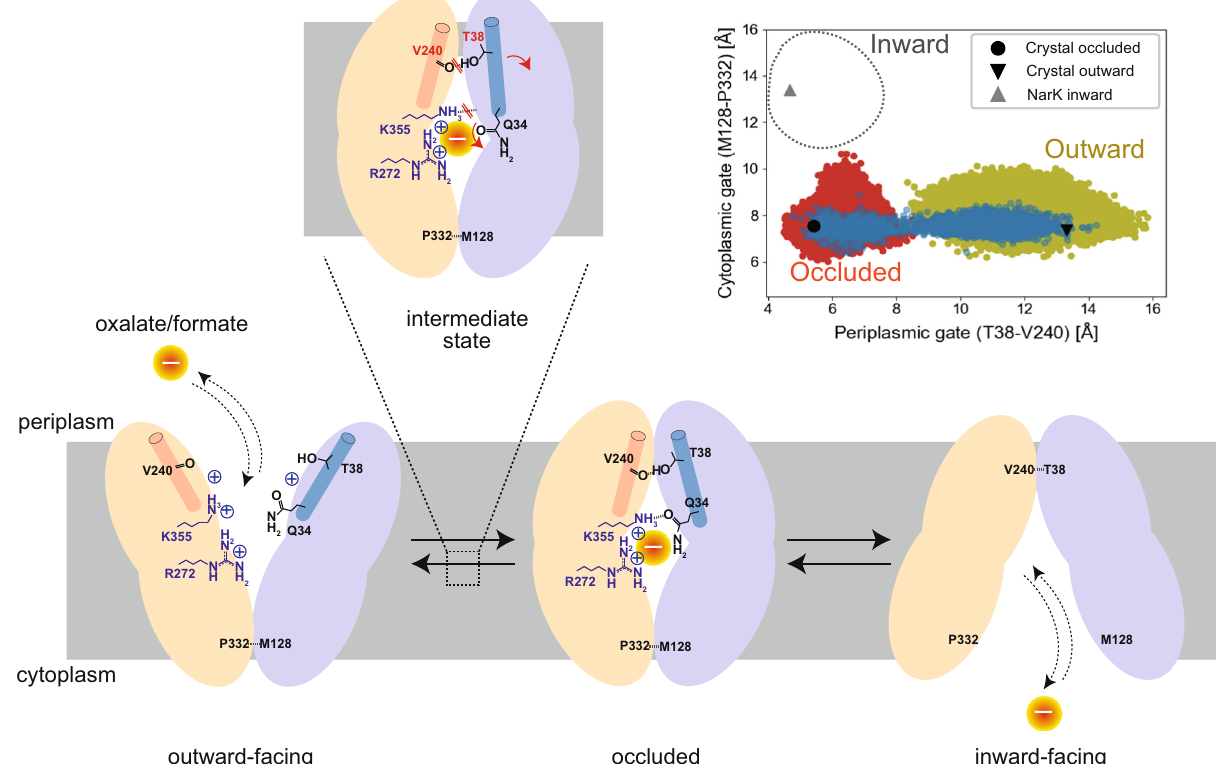
Fig. 5 | Schematic drawing of the transport process and conformational switching of OxlT. The conformational landscape of OxlT along the periplasmic andcytoplasmicgatedistancesisshowninthetoprightpanel.TheC α distancesof the gate residues in MD simulations of the occluded and outward-open states and